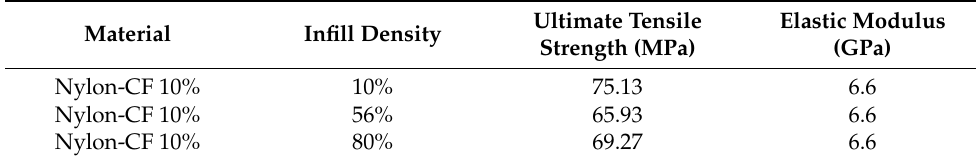
Figure 20. Effect of infill density on tensile strength of CFRAM nylon-CF. Table 4. Effect of infill density on tensile properties of nylon.